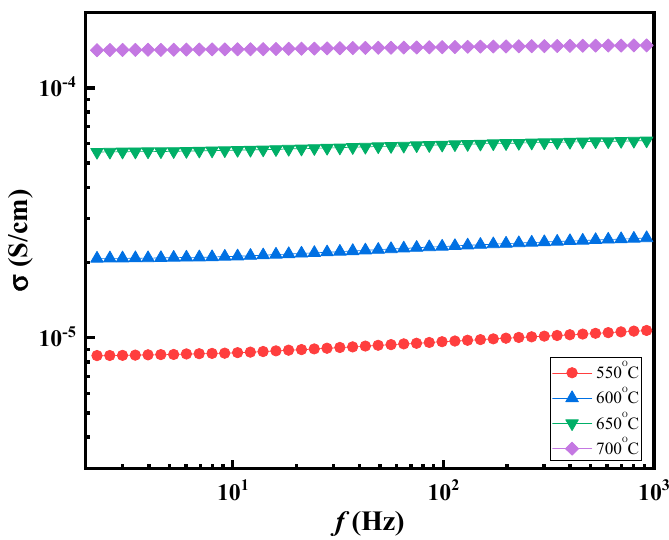
Figure 8. The ac conductivity of Fe-substituted PMN-32PT relaxor ferroelectric crystals as a function of frequency at different temperatures.